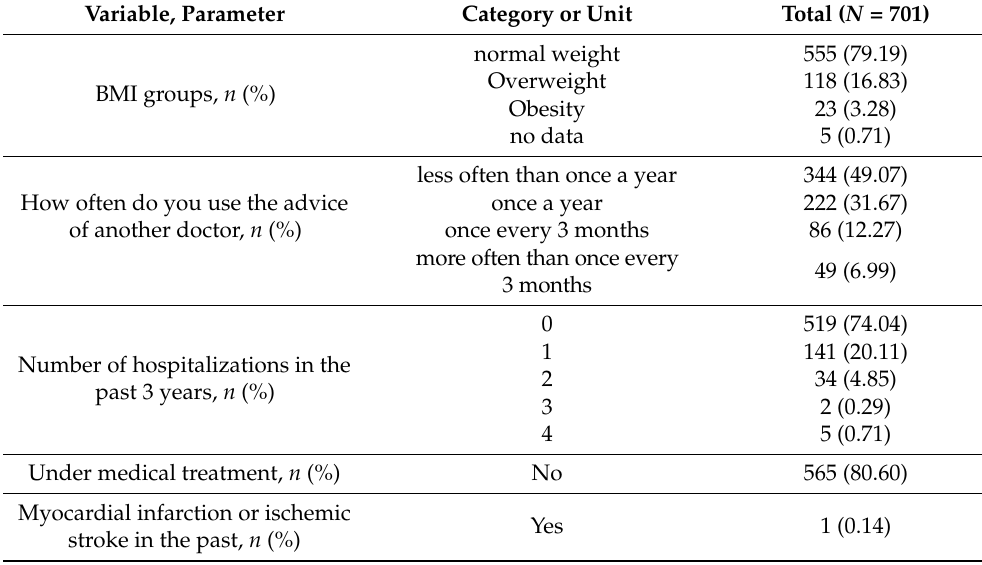
Table 3. Health characteristics of the study group.